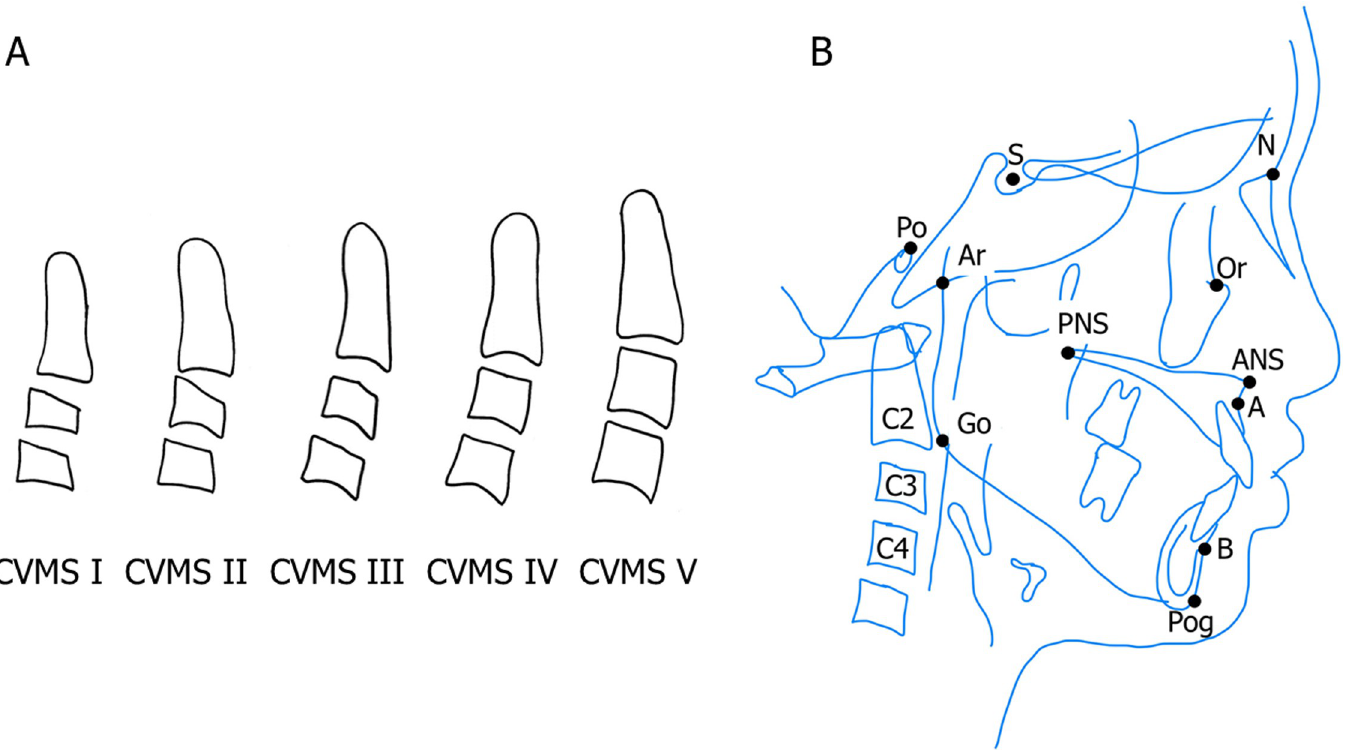
Fig 1. A. Definitions of CVMS. CVMS I: The lower borders of three vertebrae are flat. CVMS II: Concavities at the lower borders of both C2 and C3 are present. CVMS III: Concavities at the lower borders of C2, C3, and C4 are present. CVMS IV: At least one of the bodies of C3 and C4 is squared in shape. CVMS V: At least one of the bodies of C3 and C4 is rectangular vertical in shape. B. Cephalometric landmarks used to construct the two linear measurements and angular measurements analyzed in this study. Linear parameters: ANS-PNS; Distance between ANS and PNS, Ar-Go; Distance between Articulare and Gonion, Go-Pog; Distance between Gonion and Pogonion. Angular parameters: FMA; Mandibular plane to Frankfort-Horizontal plane, SNA; Sella-Nasion to Point A, SNB; Sella-Nasion to Point